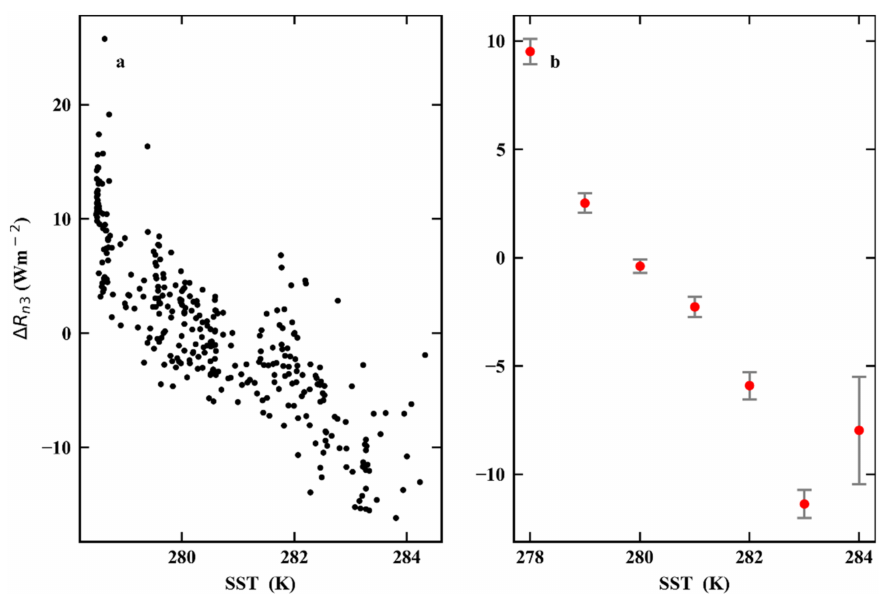
Figure 9. The same as Figure 4 but for the model residuals ∆ R n3 and